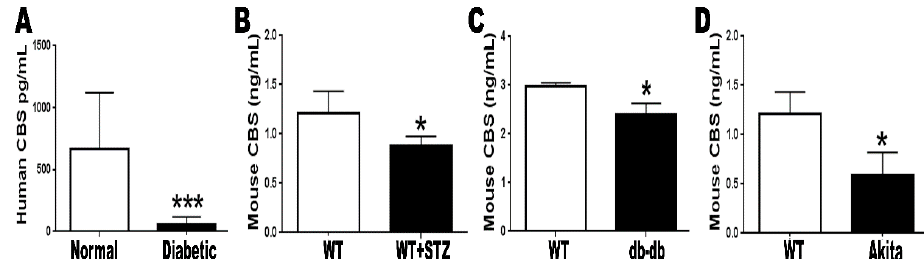
Figure 3. Assessment of cystathionine beta-synthase (CBS) level by ELISA. ( A ) Serum samples from diabetic patients demonstrated a significant decrease in CBS level compared to the control non-diabetic group (*** p < 0.001). ( B ) STZ-injected mice, ( C ) db/db mice and ( D ) Akita mice demonstrated a significant decrease in blood CBS level compared to corresponding control groups (* p <